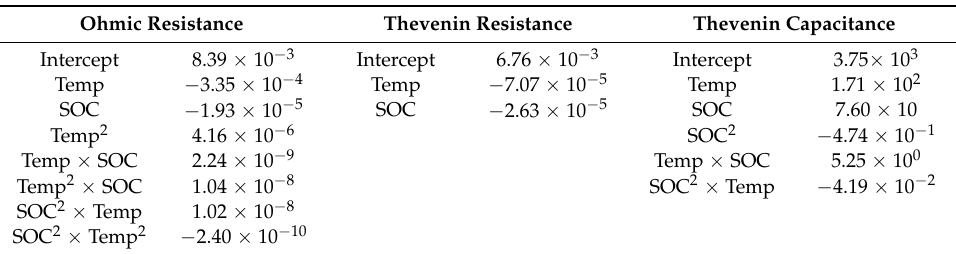
Table 5. The final parameter values for the response surface of ohmic resistance, Thevenin resistance and Thevenin